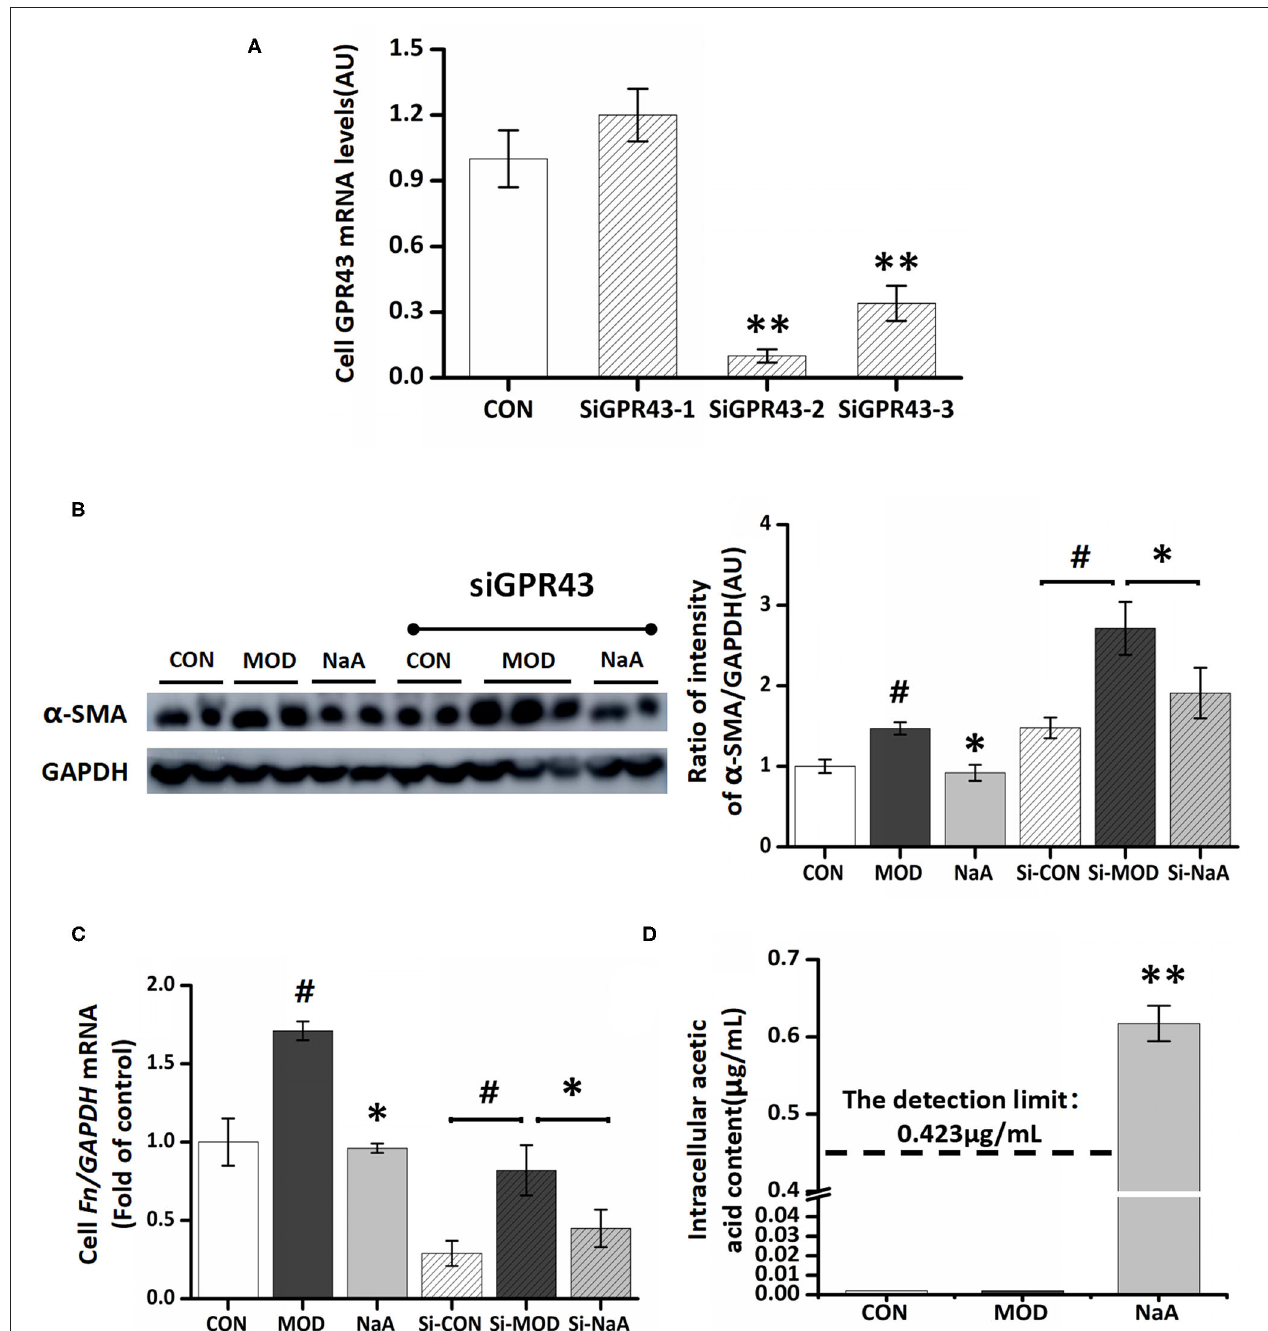
FIGURE 3 | GPR43 possessed limiting ability in the process of NaA inhibited TGF- β 1 induced HSCs activation. (A) LX2 cells were cultured and transfected with 50nM Lipofectamine ® 2000 RNAiMax reagent and GPR43 siRNA, selected the sequences with the best silence efficiency. (B) Western blot was used to evaluate the protein of α -SMA. LX2 cells were treated with or without 2.5ng/ml TGF- β 1 and 0–1mM of NaA for 48h at 24h post-transfection. (C,D) Real-time PCR was used to evaluate the mRNA expression of Col1a1 . LX2 cells were treated with or without 2.5ng/ml TGF- β 1 and 0–1mM of NaA for 48h at 24h post-transfection. LX2 cells were treated as detailed in the section Materials and Methods. For all bar graphs, data are the mean ± SD, # p < 0.05, as compared with CON, and * p < 0.05, ** p < 0.01, as compared with MOD. The significant difference was assessed using the one-way ANOVA followed by LSD post-tests. Control group (CON), group model cell treated with a TGF- β 1 (MOD), sodium acetate (NaA), arbitrary unit (AU).